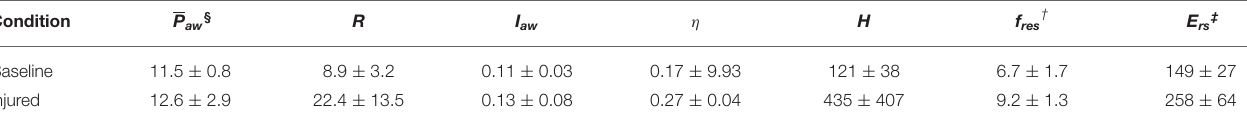
TABLE 1 | Respiratory system